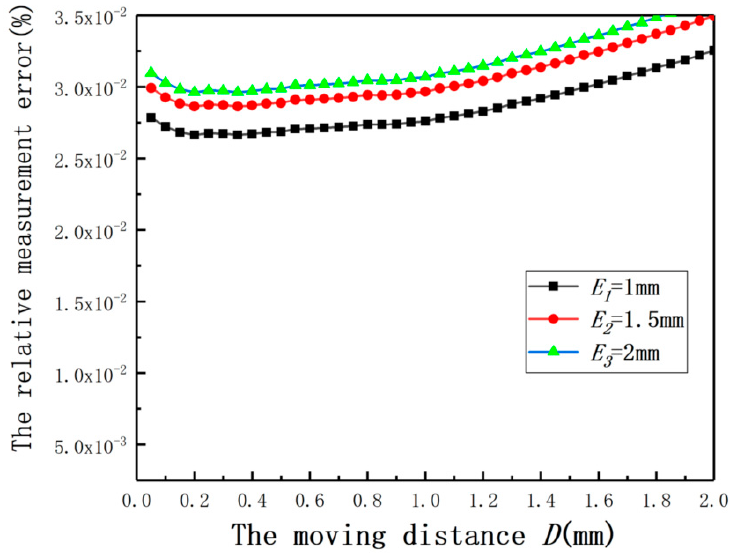
Figure 32. The relative measurement errors after compensation under different eccentricities.